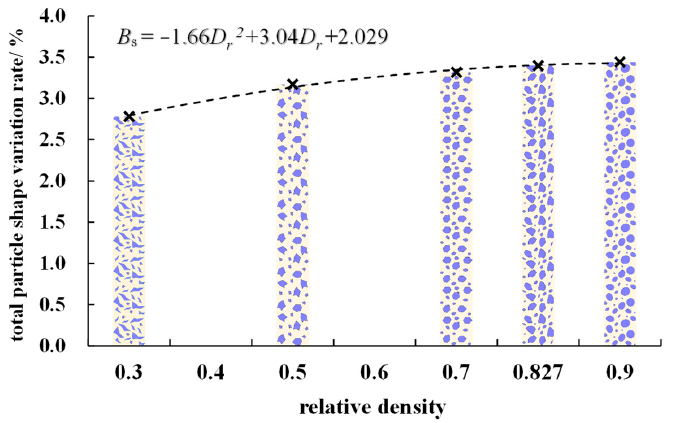
Figure 19. The effect of soil bulk density on the total particle shape of silt.